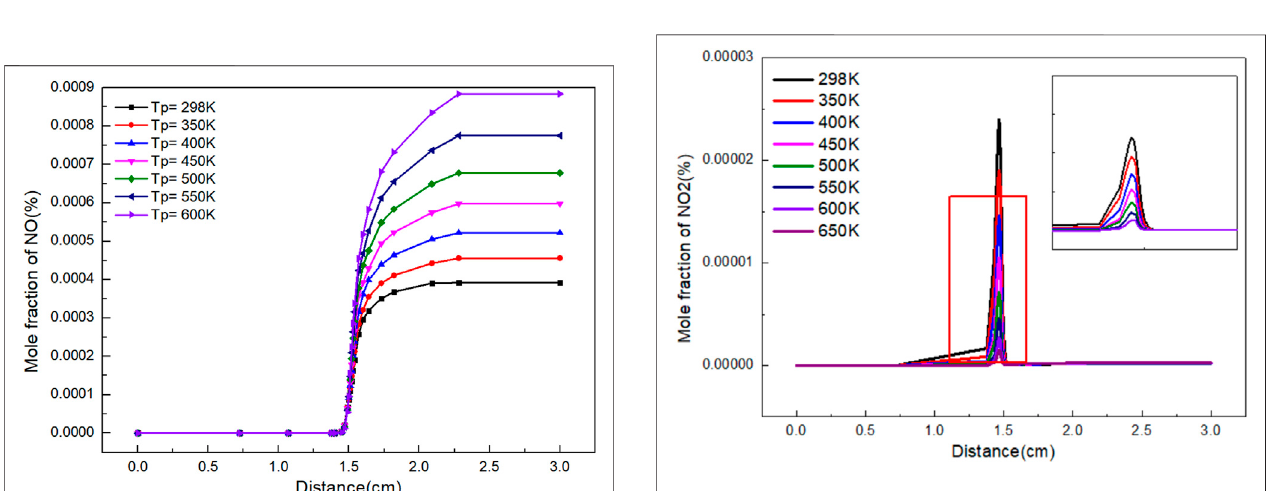
FIGURE 5 | Variation of NO 2 mole fraction with fl ame distance under different preheating temperature.